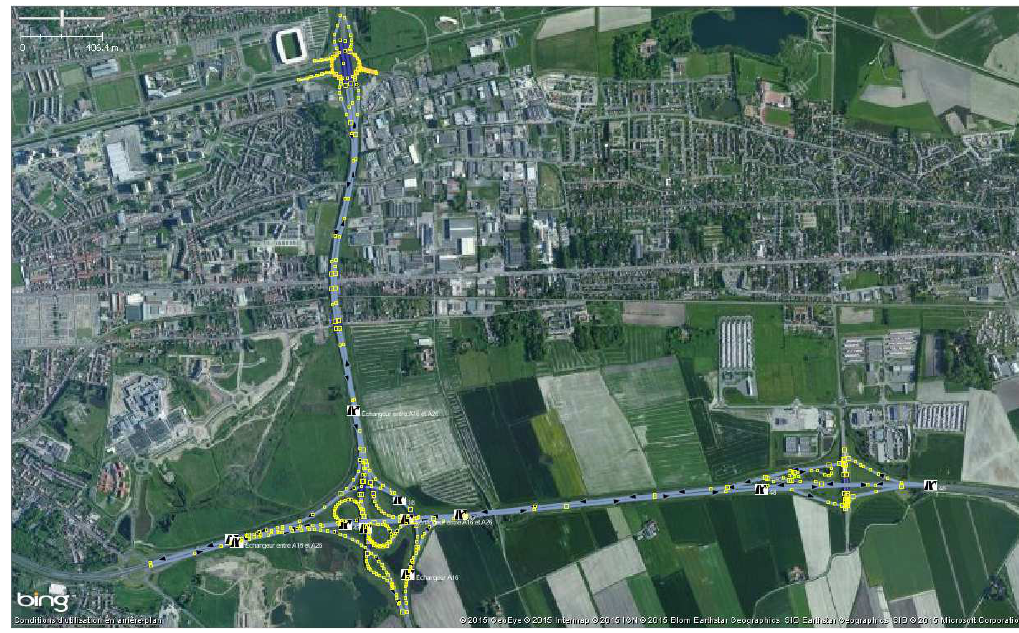
Figure 3. Aerial view of the OSM road